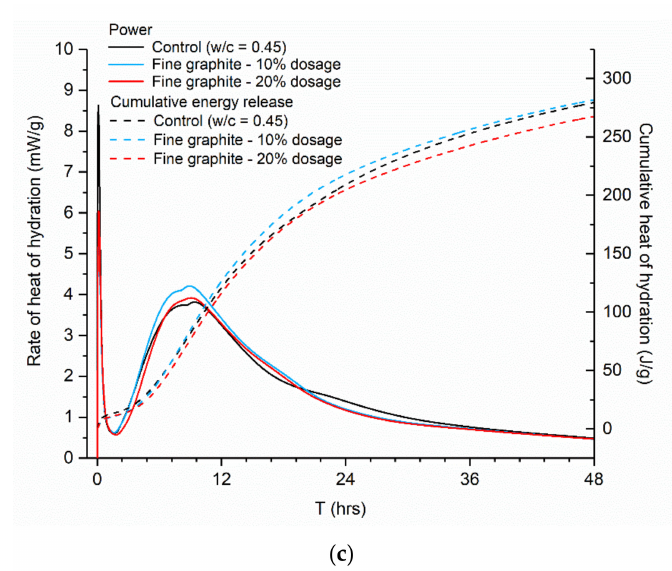
Figure 7. E ff ect of graphite size and concentration on the hydration of CEMI paste, measured by isothermal calorimetry: ( a ) coarse, ( b ) medium, and ( c ) fine